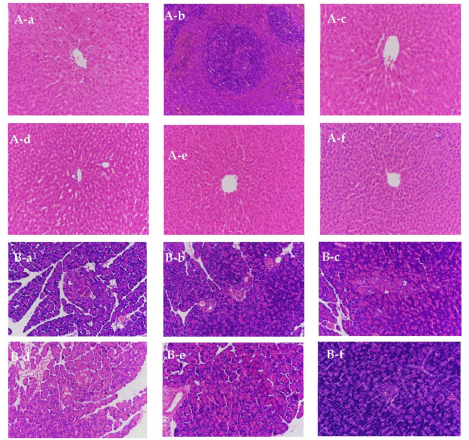
Figure 5. Effects of oral SS administration on HE staining in the liver ( A ) and pancreas tissues ( B ) of T2D rats ( × 100); a , normal group; b , diabetic model group; c , metformin administration; d , 1% SS (LSS); e , 2.5% SS (MSS); and f , 5% SS (HSS)